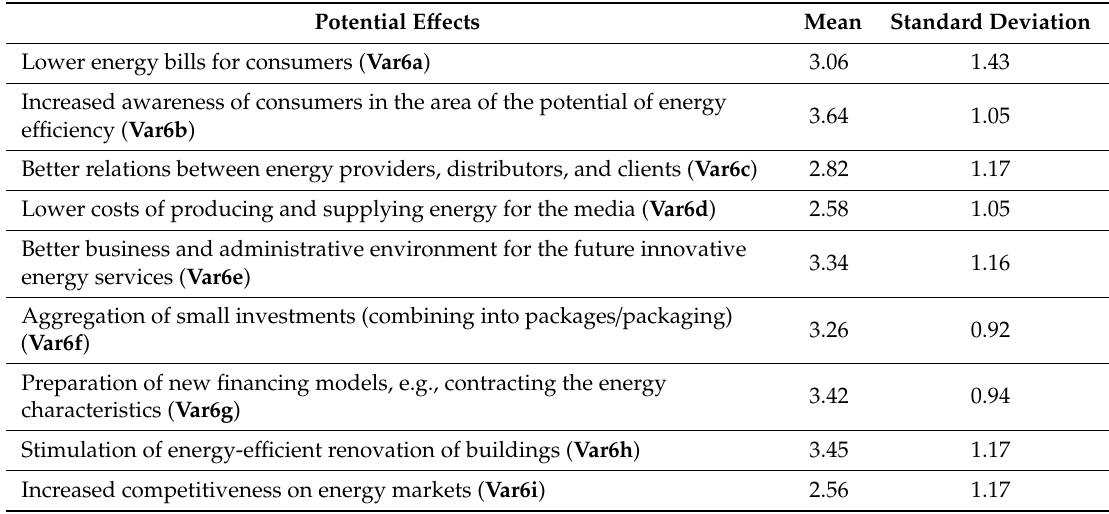
Table 3. Mean score of the potential e ff ects of implementing the energy e ffi ciency